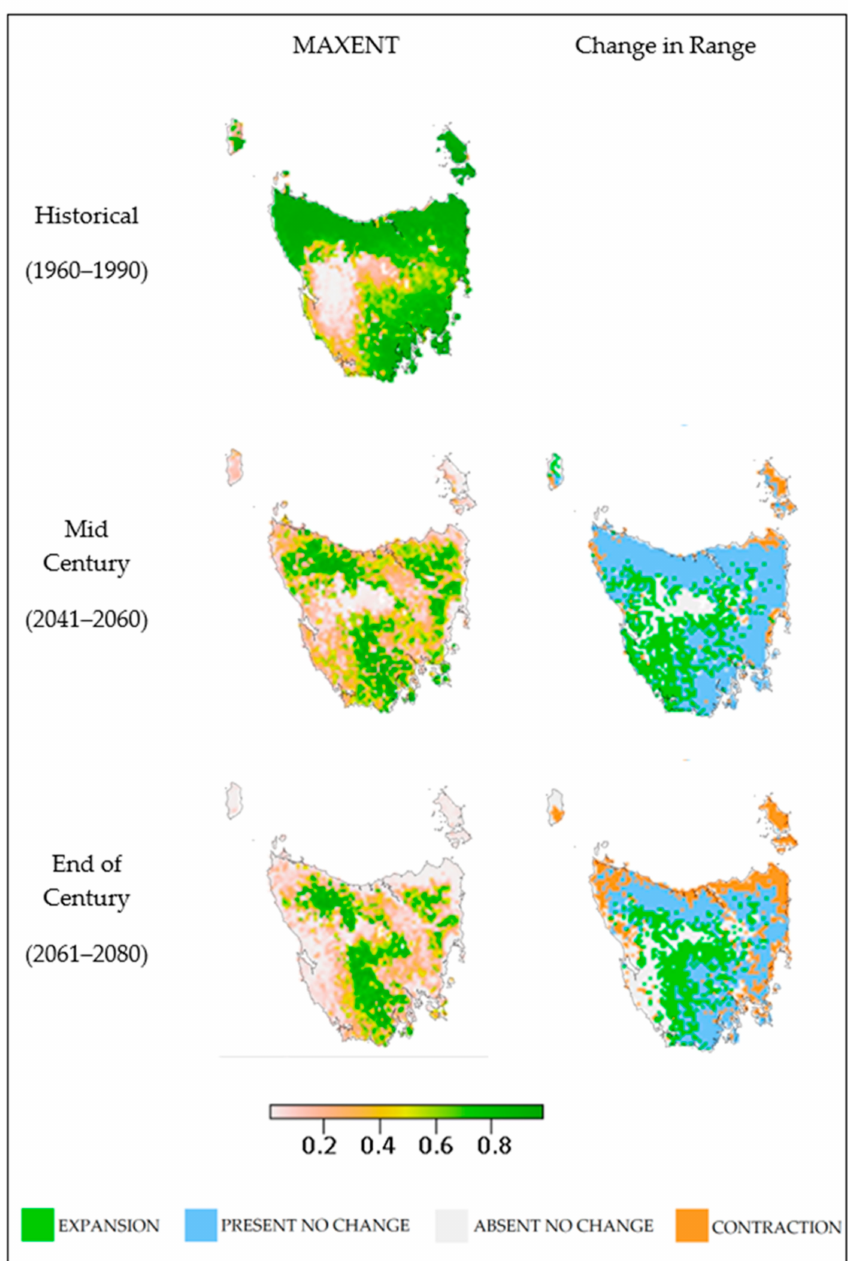
Figure 5. Environmental suitability for E. obliqua in Tasmania, shown as a probability of occurrence, and change in species range projected under historical (1960–1990) and future climates for mid (2041–2060) and end of century (2060–2081), as modelled by SDM Maxent and GCM